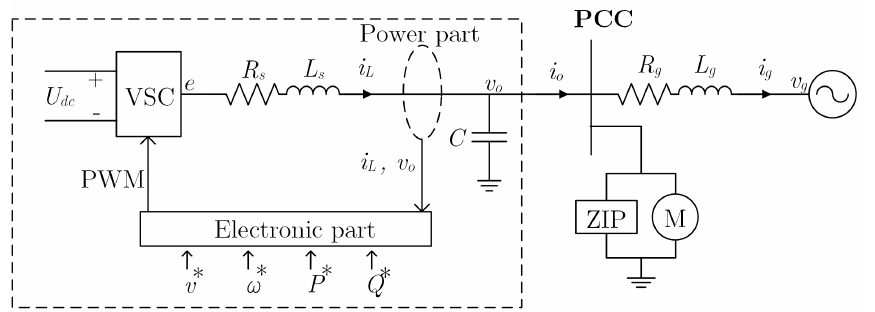
Figure 1. Grid-connected synchronverter.